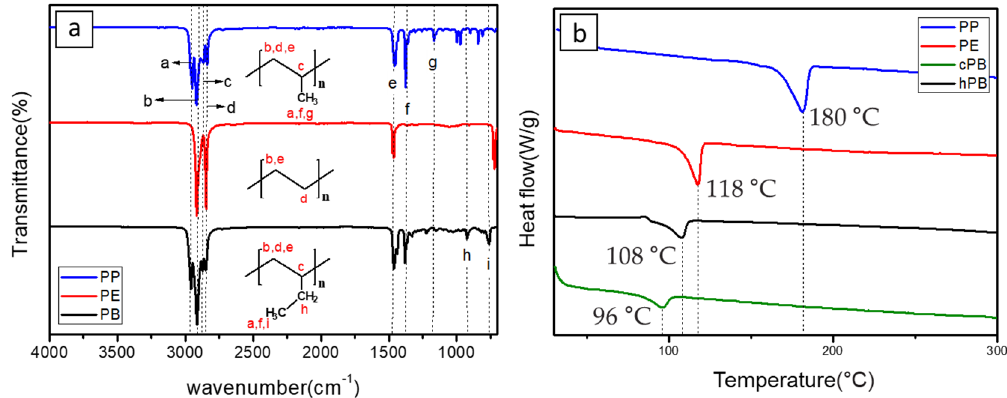
Figure 1. ( a ) FTIR spectra and ( b ) DCS thermograms of PP, PE, cPB, and Figure 1. ( a )FTIR spectra and ( b ) DCS thermograms of PP, PE, cPB, and hPB. Table 2. IR spectra data of PP, PE and PB.